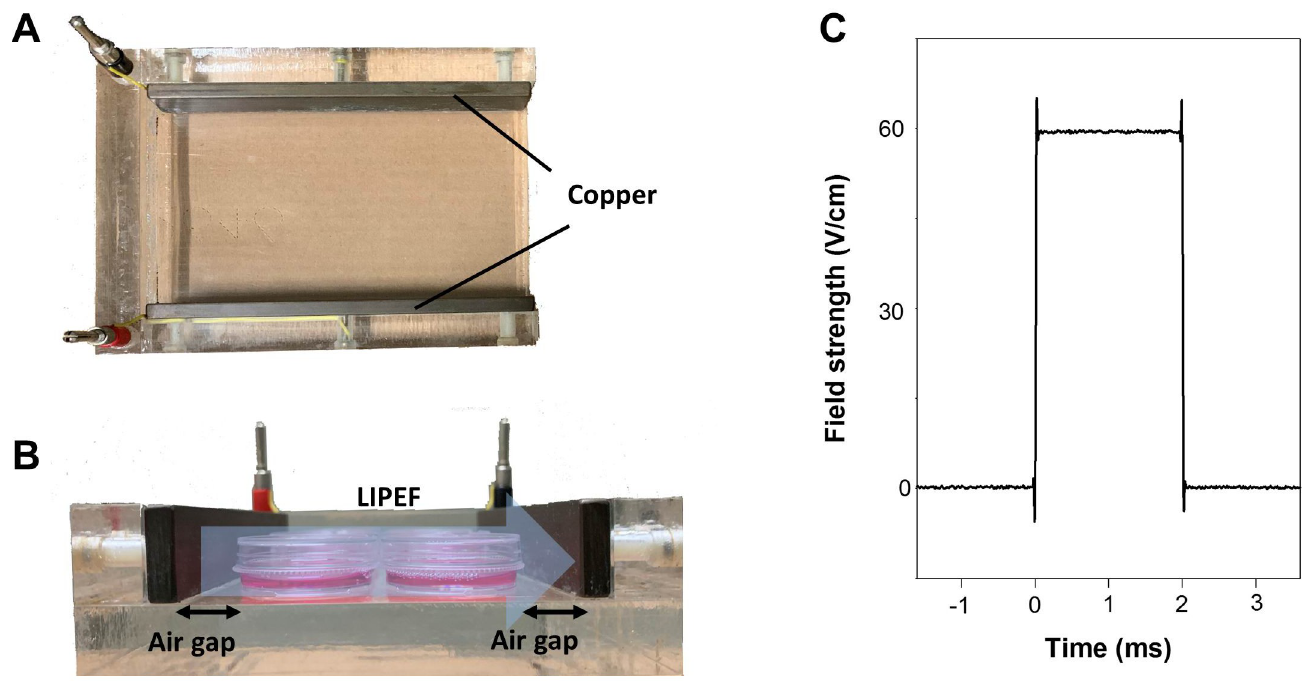
Fig 1. Experimental device and waveform for the exposure to LIPEF. (A) A photo of the electric field stimulation device. (B) The cells seeded in a culture well were located in the stimulation device constructed of two parallel copper plates. Electric fields of 30, 60, and 90 V/cm were introduced between electrodes. The light blue arrow shown here indicates the schematic representation of non-invasive LIPEF exposure on cells. (C) The waveform of 60V/cm LIPEF applied on the